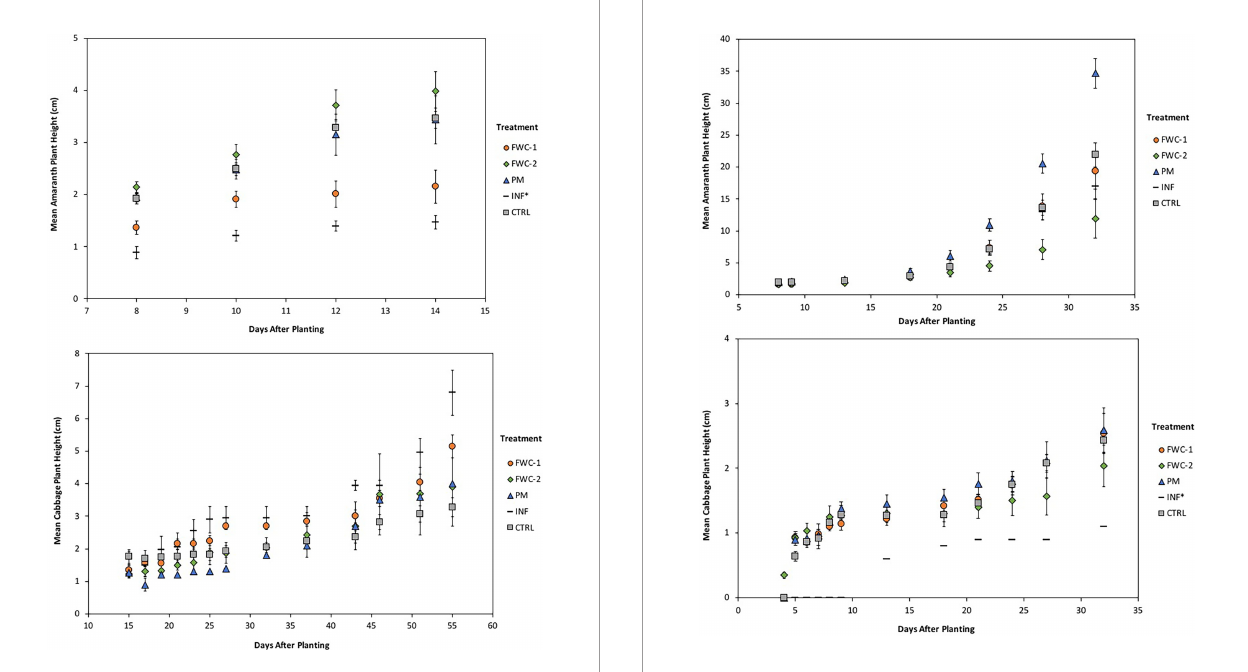
FIGURE 6 | (Top) Growth of amaranth greens for the second planting from 8 to 32 days after planting. From 24 to 32 days after planting, growth in PM treatments exceeds other treatments, growth in FWC-1, CTRL, and INF are similar and exceed growth in FWC-2 treatment. (Bottom) Growth of cabbage for the second planting is shown from 7 to 27 days after planting. The growth in all treatments follows closely with one another until 21 days after planting at which point growth in PM, FWC-1, and CTRL treatments exceeds that of FWC-2 treatments. Cabbage growth INF* treatments is shown without standard error bars because only one seed germinated (excluded from statistical